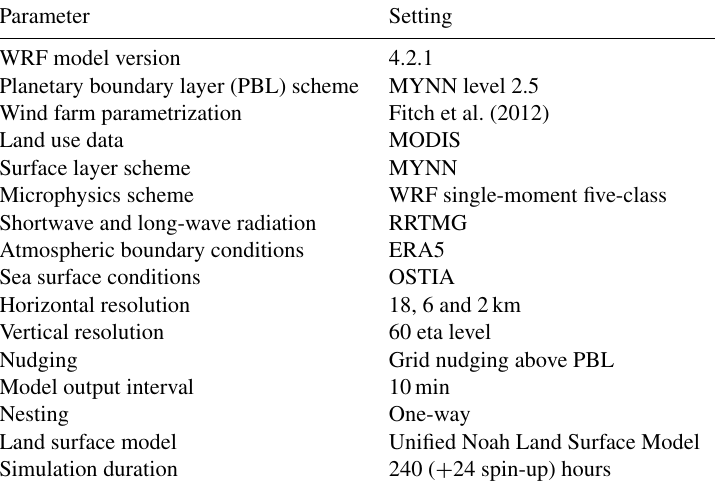
Table 4. Relevant parameters of the mesoscale model set-up. The references for the different schemes and models are summarized in WRF Users Page